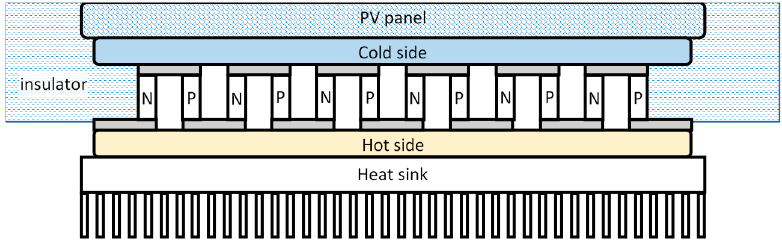
Figure 1. Photovoltaic–thermoelectric cooler (PV-TEC) structure.